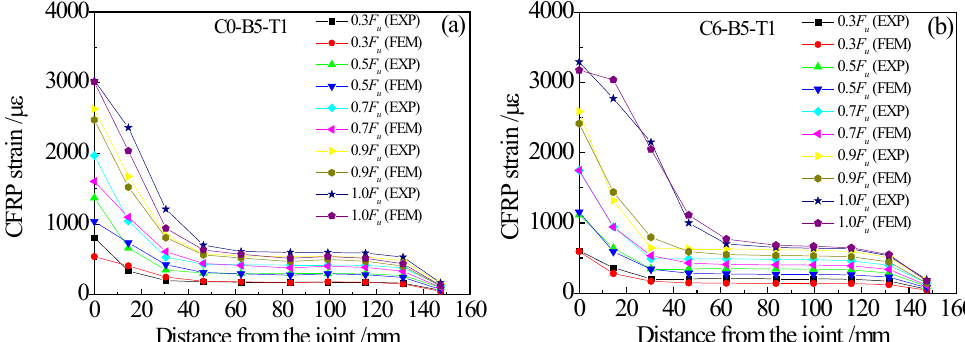
Figure 16. Comparison between the predicted and tested strain distribution of CFRP plates: ( a ) specimen C0-B5-T1, ( b ) specimen C6-B5-T1.